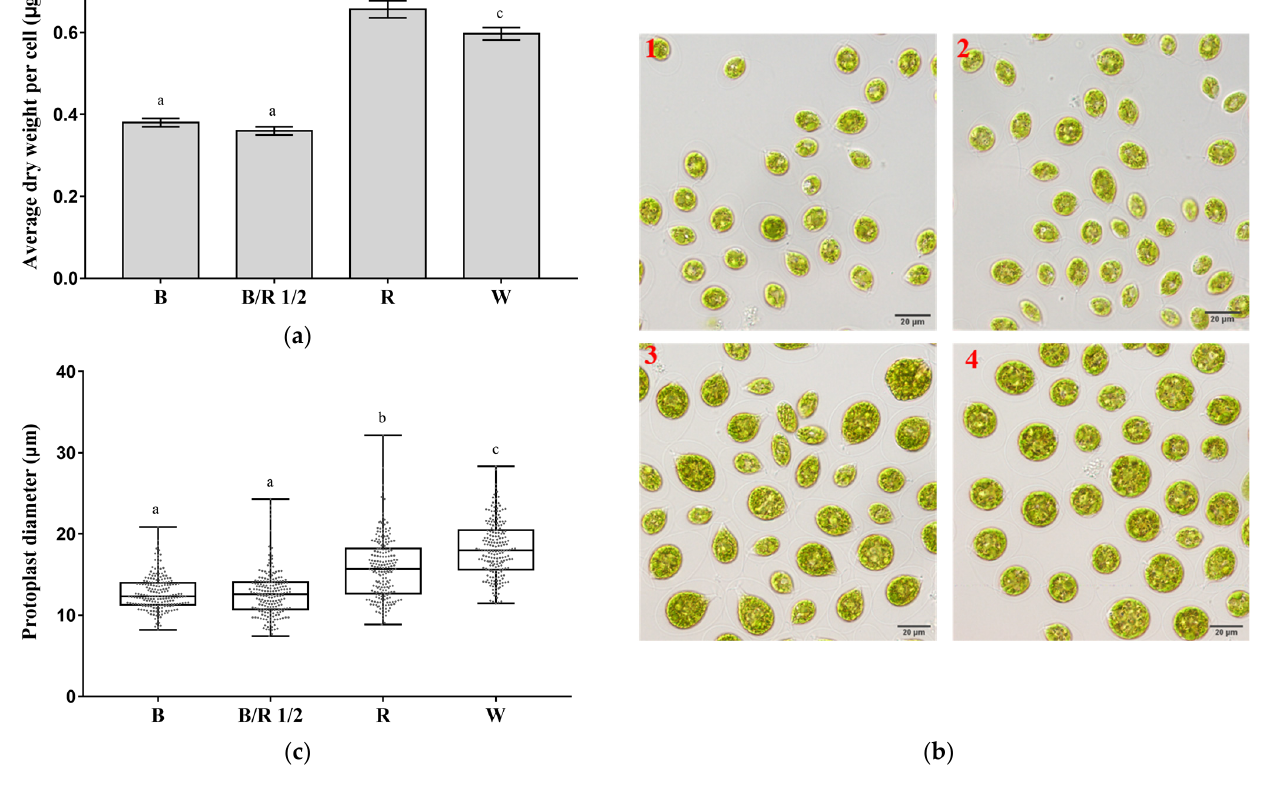
Figure 2. Effects of light spectra on the sizes of H. pluvialis green cells. ( a ) Average dry weight per cell at the end of cultivation; ( b ) micrographs of the cells at the end of cultivation with scale bar of 20 μ m: ( 1 ) Blue light; ( 2 ) blue/red light 1/2; ( 3 ) red light; ( 4 ) white light. ( c ) Distribution of protoplast diameters at the end of cultivation (a total of 200 randomly selected cells were measured manually for each light condition). In ( a , c ), the same lowercase letter means insignificant difference, while different lowercase letters mean significant difference. In ( a , c ), B—Blue light; B/R 1/2—blue/red light 1/2; R—red light; W—white light.